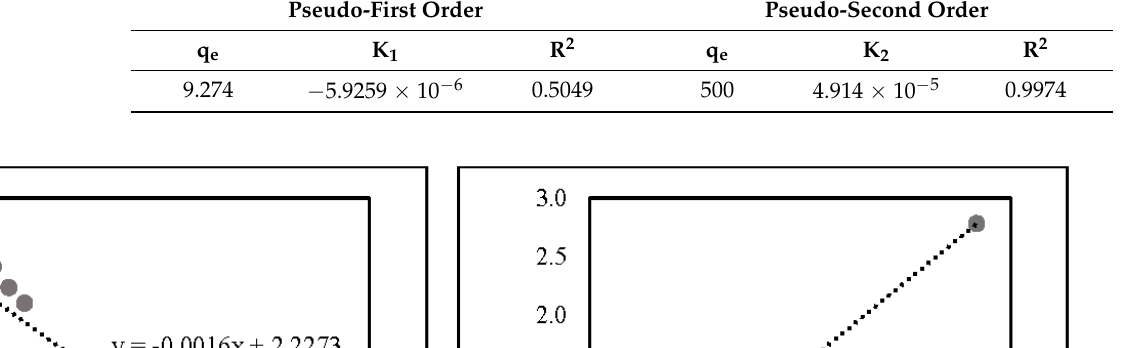
Table 2. Pseudo-first-order and Pseudo-second order kinetics models of nitrate adsorption onto ZLCH-Fe.